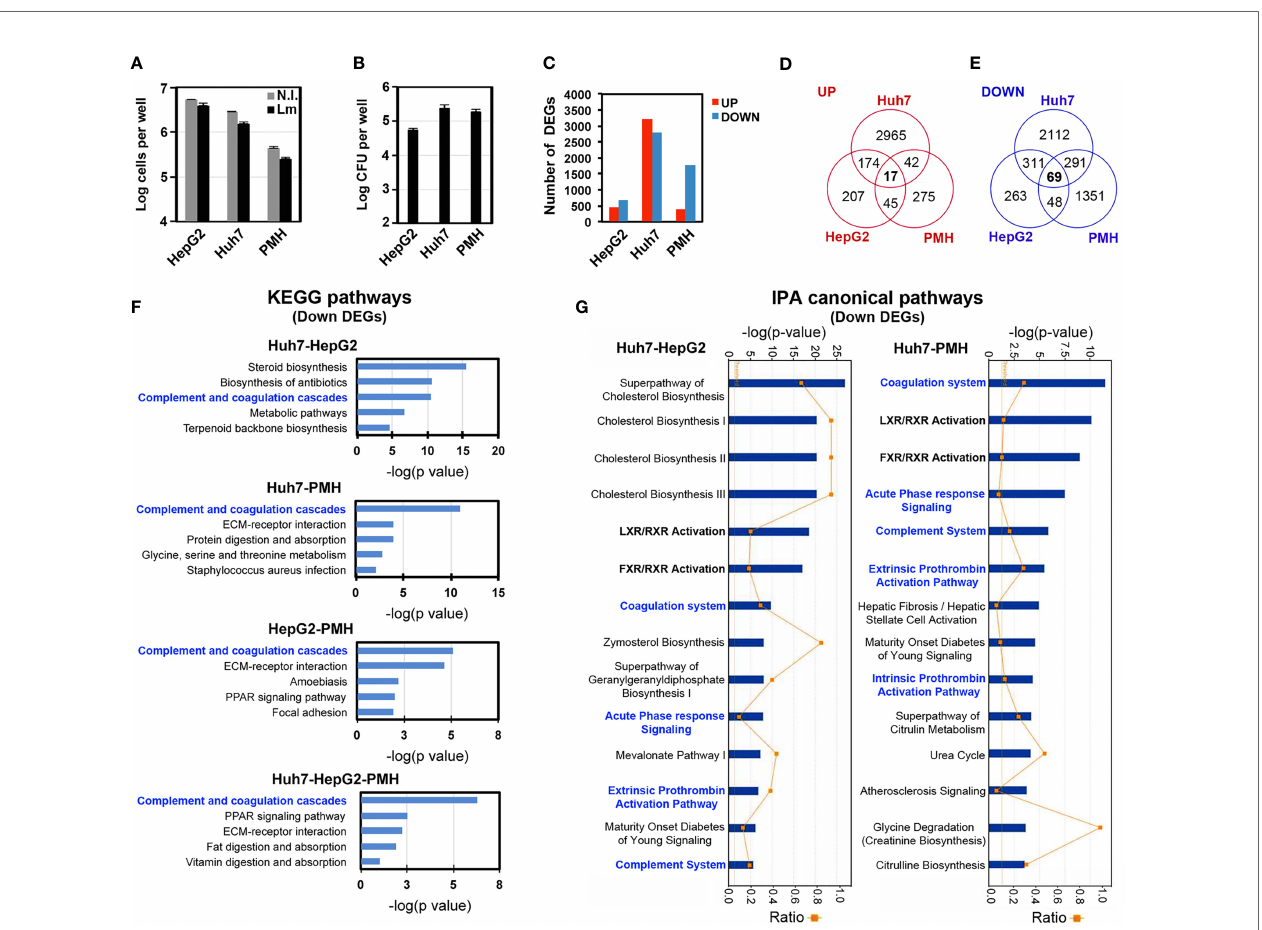
FIGURE 2 | Transcriptional responses to long-term Listeria infection in hepatocytes. HepG2, Huh7 and PMH were infected with Listeria for 72 h. (A) Cell counts (log cells per well, mean ±SD, n=3). (B) Intracellular bacteria load expressed as log CFU per well (mean ±SD, n=3). (C) Number of signi fi cant DEGs upregulated (red bars) or downregulated (blue bars) in infected hepatocytes compared to non-infected hepatocytes (adj p <0.05; |log2 FC| > 0.5). (D, E) Venn diagram showing the intersection of upregulated (D) and downregulated (E) DEGs between HepG2, Huh7 and PMH datasets. (F) The top 5 most signi fi cant KEGG pathways associated with downregulated DEGs in each of the 4 overlapping DEG datasets. (G) The top 14 most signi fi cant IPA canonical pathways associated with the Huh7 – HepG2 (left) and the Huh7 – PMH (right) overlapping downregulated